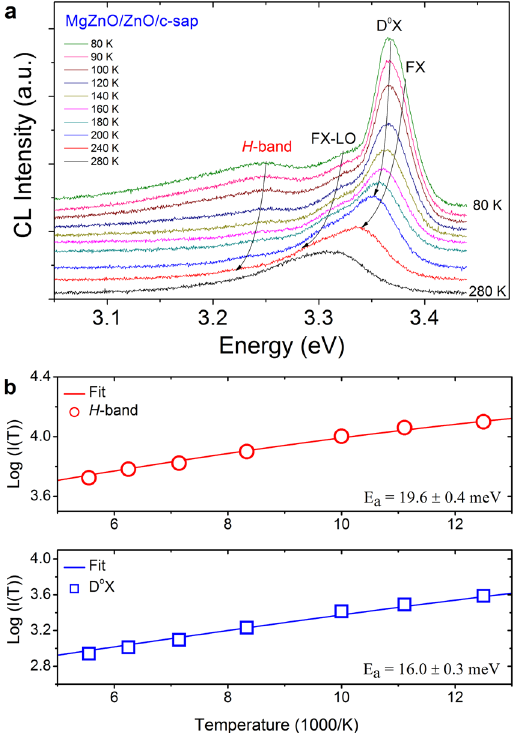
Figure 4. Temperature-resolved CL measurements of the MgZnO/ZnO bilayer. ( a ) Temperature-dependent CL spectra of the bilayer acquired at an acceleration voltage of 7 kV. The H -band is identifiable at temperatures up to 160 K. ( b ) Variations of the H -band and D 0 X peak intensities as a function of temperature. Activation energies of 19.6 meV and 16.0 meV were determined by fitting these data according to the Arrhenius equation.